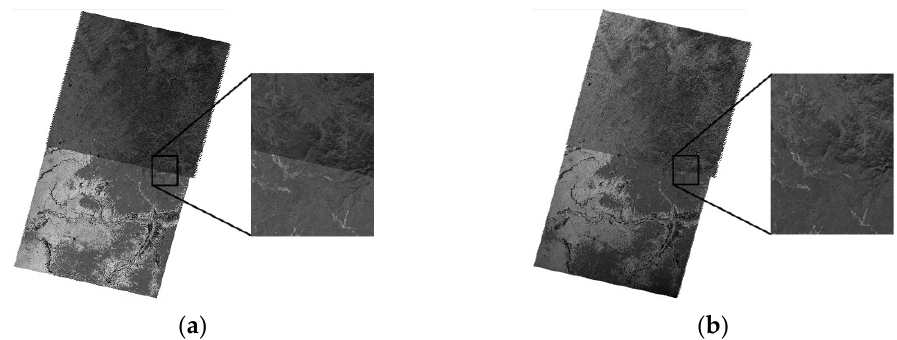
Figure 12. Compare with original image and the result by using brightness approach model. ( a ) Original image. ( b ) The result by using brightness approach model.